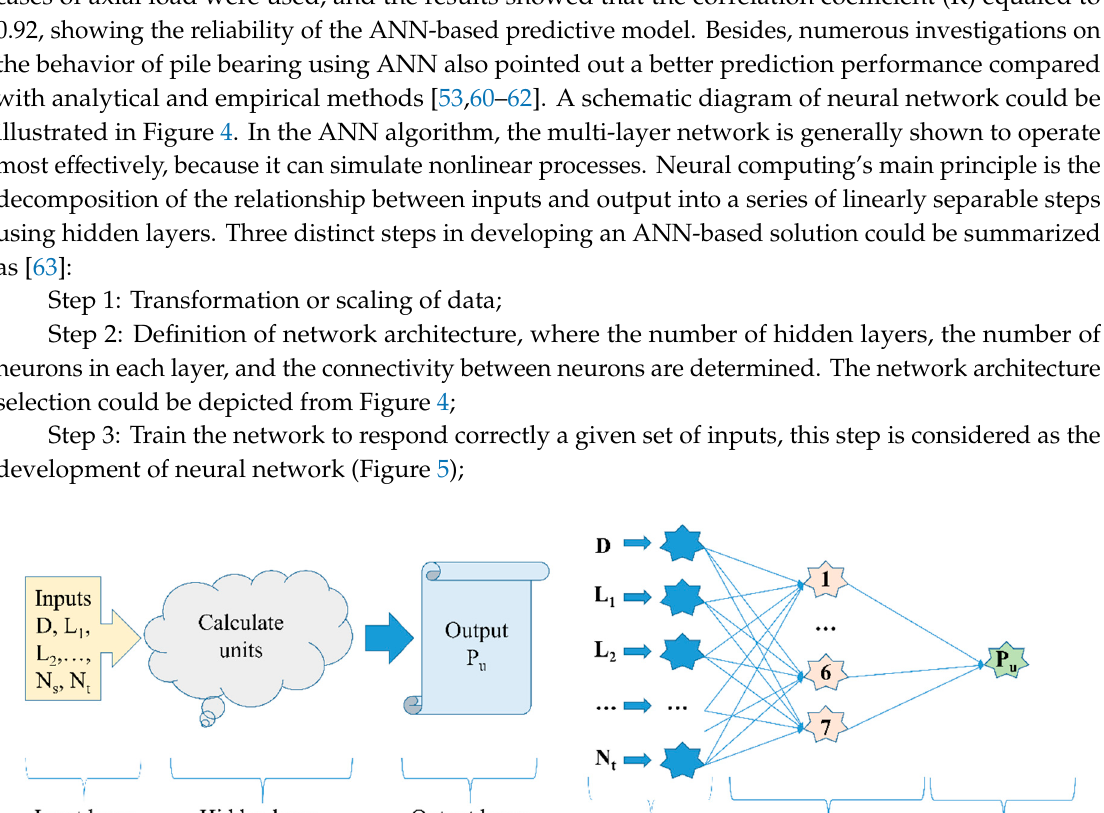
Figure 4. ( Left ) Schematic diagram of neural network and ( Right ) network architecture selection.